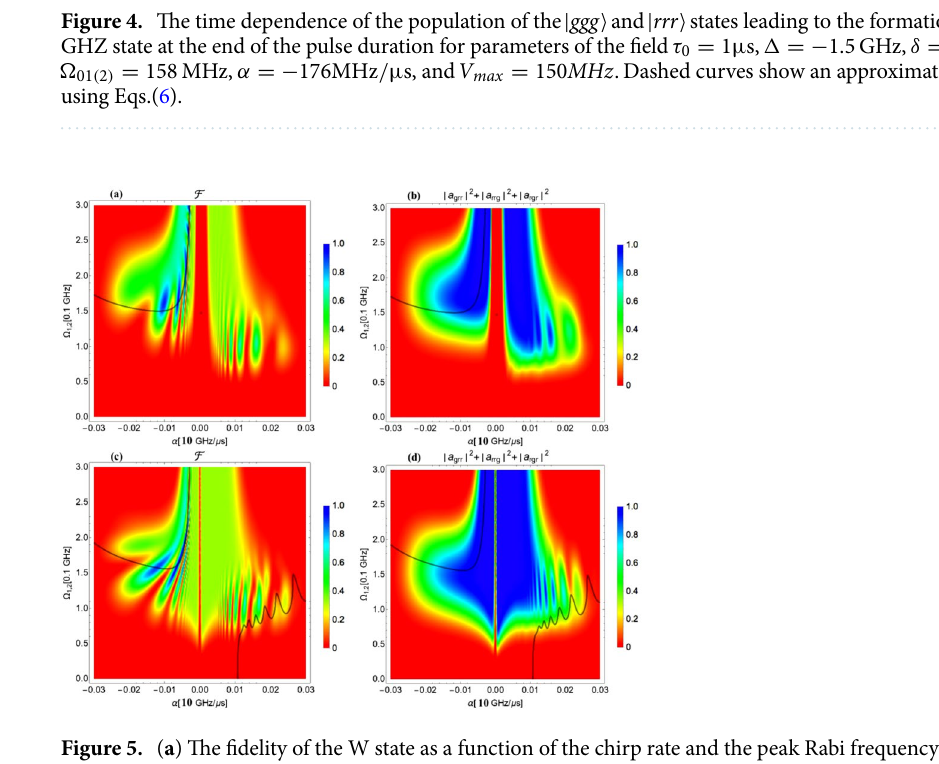
, rrg grr rgr , and the | � | � | �